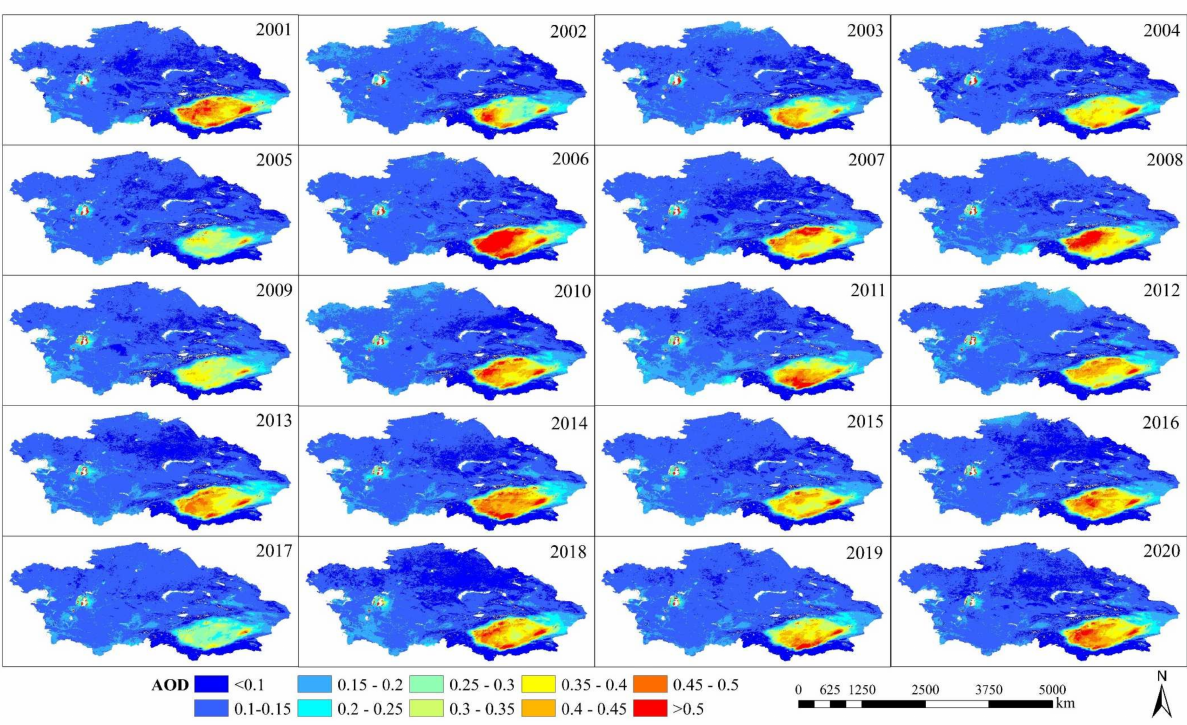
Figure 6. Inter-annual distribution of the AOD in Central